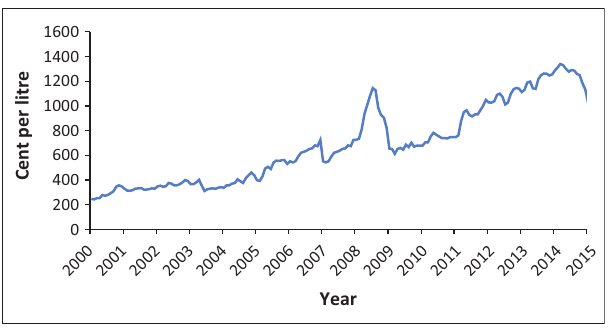
FIGURE 5: South Africa’s diesel price trend.